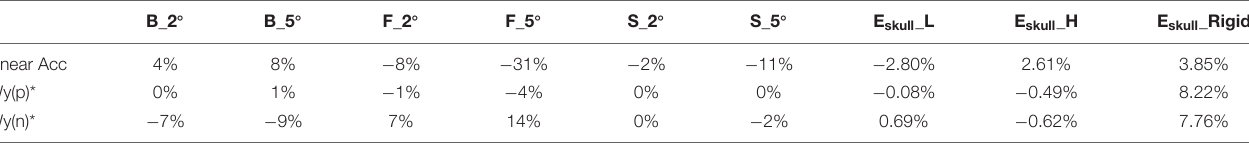
TABLE 6 | Kinematics changes compare to Flat